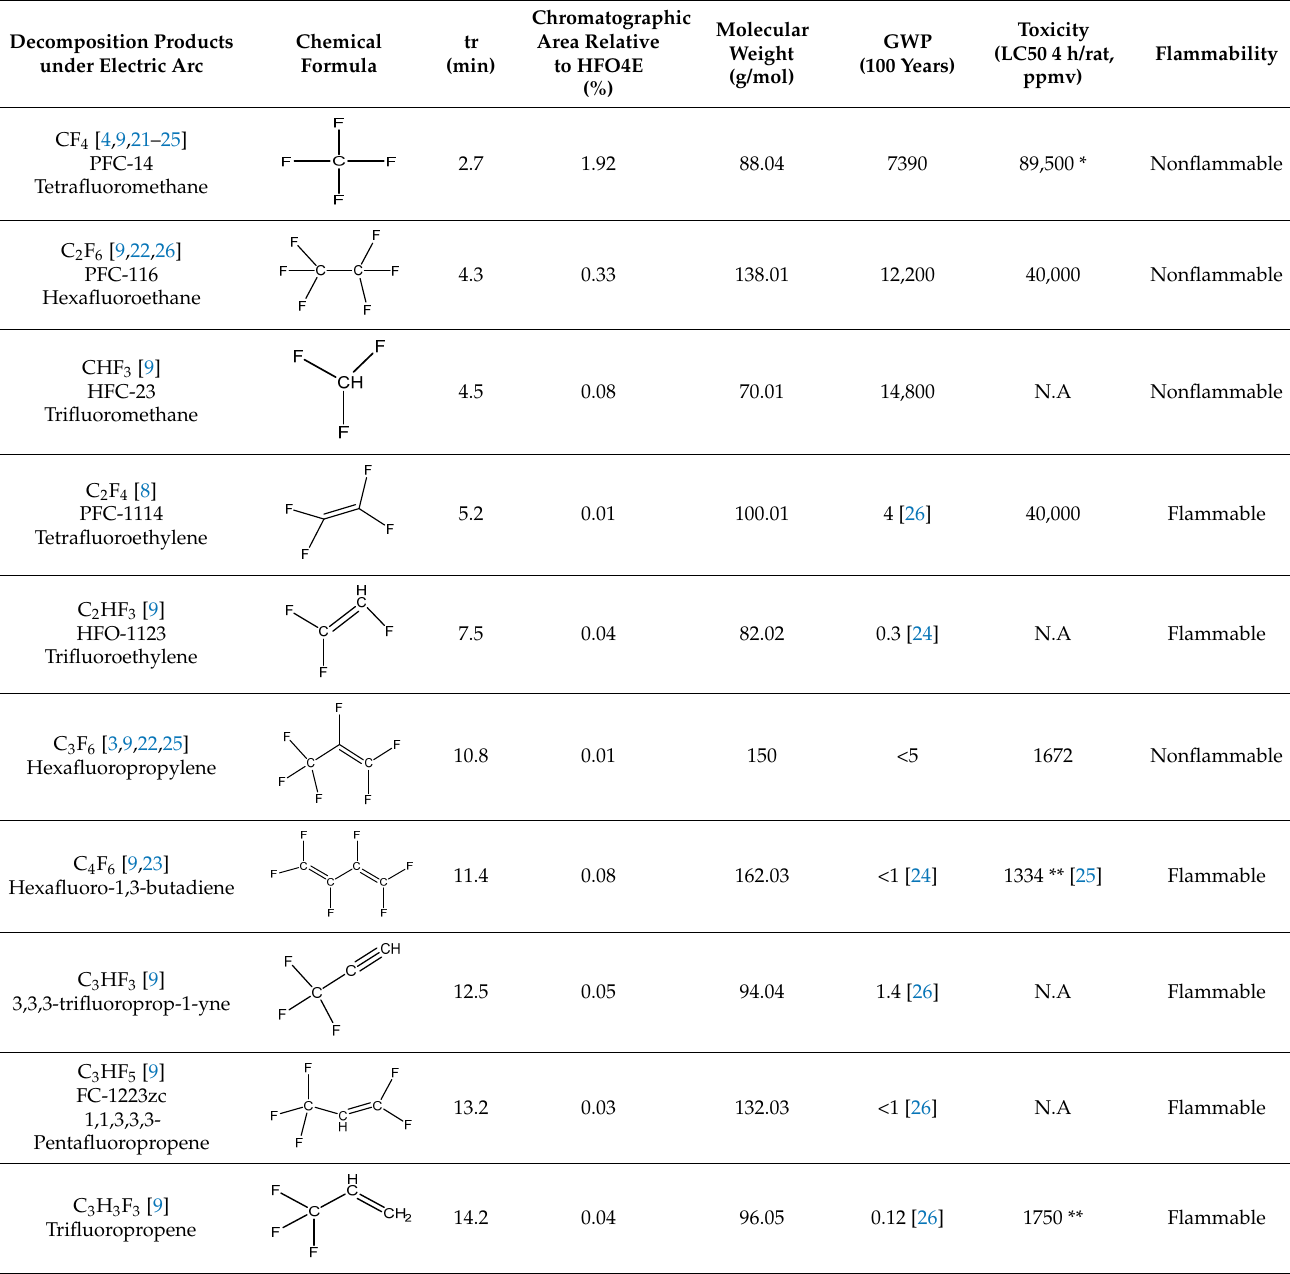
Table 4. Retention times (tr) and physicochemical properties of decomposition products identified after the application to electric arcs of 20 and 140 kJ to the medium-voltage switchgear.